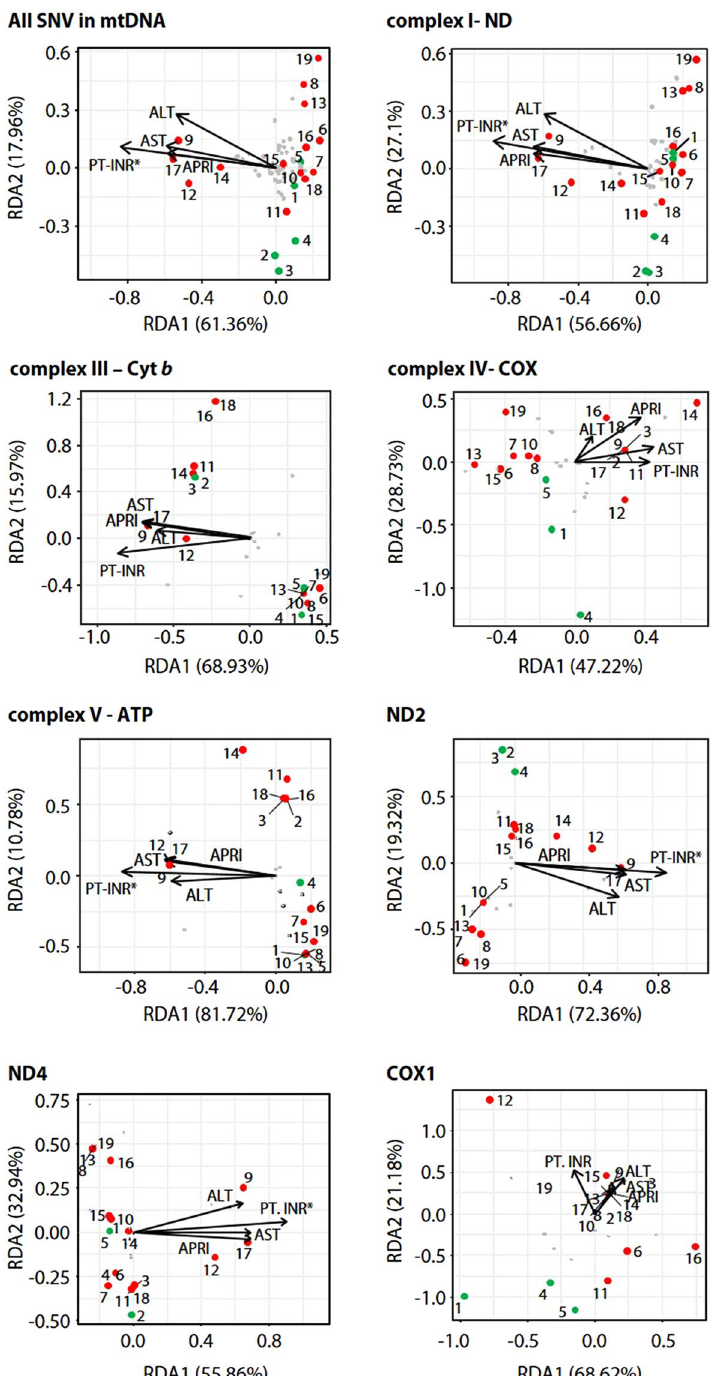
Figure 3. Redundancy analysis triplot of 14 BA and 5 CC patients in their genetic variations and relevant clinical factors. BA (red circles) and CC (green circles) patients; * , statistically significant predictors of the phenotype distribution (anova.cca permutation test, P <